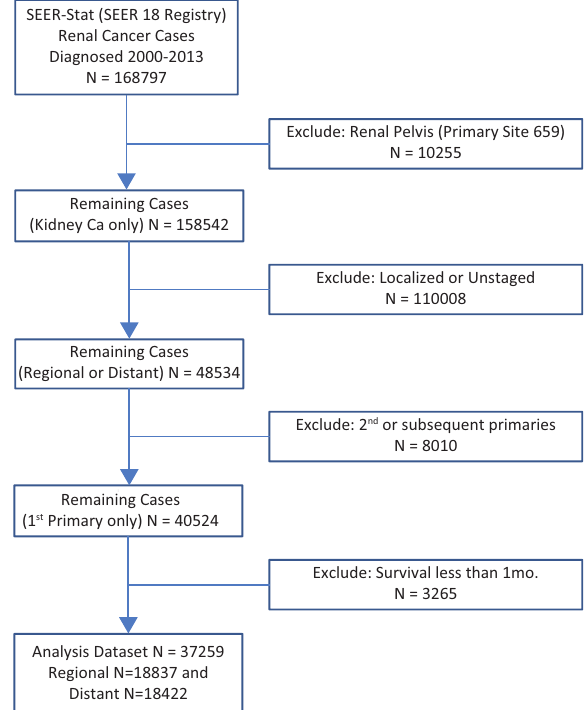
Figure 1: Consort diagram of patient population included in